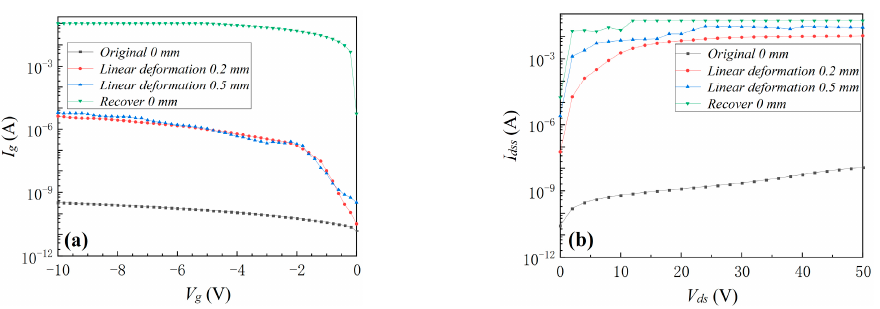
Figure 5. The device’s I g ( a ) and I dss ( b ) before/after linear deformation of 0.2 and 0.5 mm and recovery to 0 mm.